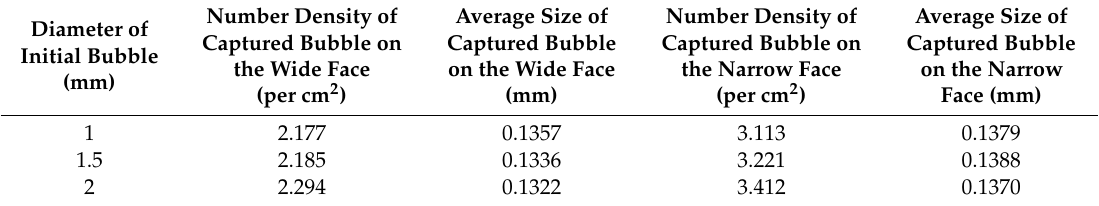
Table 4. Captured bubble distribution with di ff erent initial bubble sizes at the operation casting speed of 1.3 m / min and gas flow rate of 8.2% gas volume fraction.